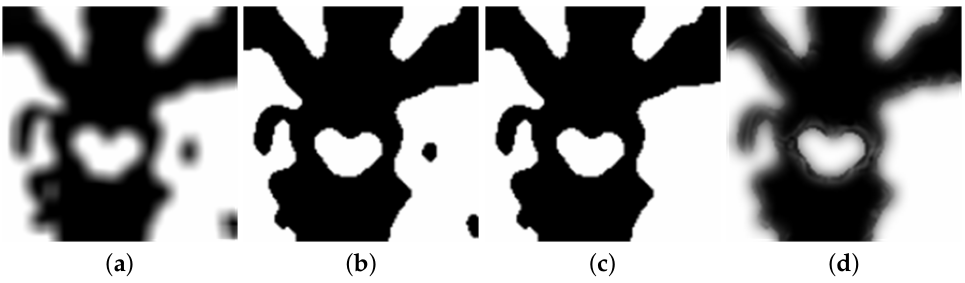
Figure 10. ( a ) Focus detection. ( b ) Initial segmentation. ( c ) Initial decision map. ( d ) Final decision map.